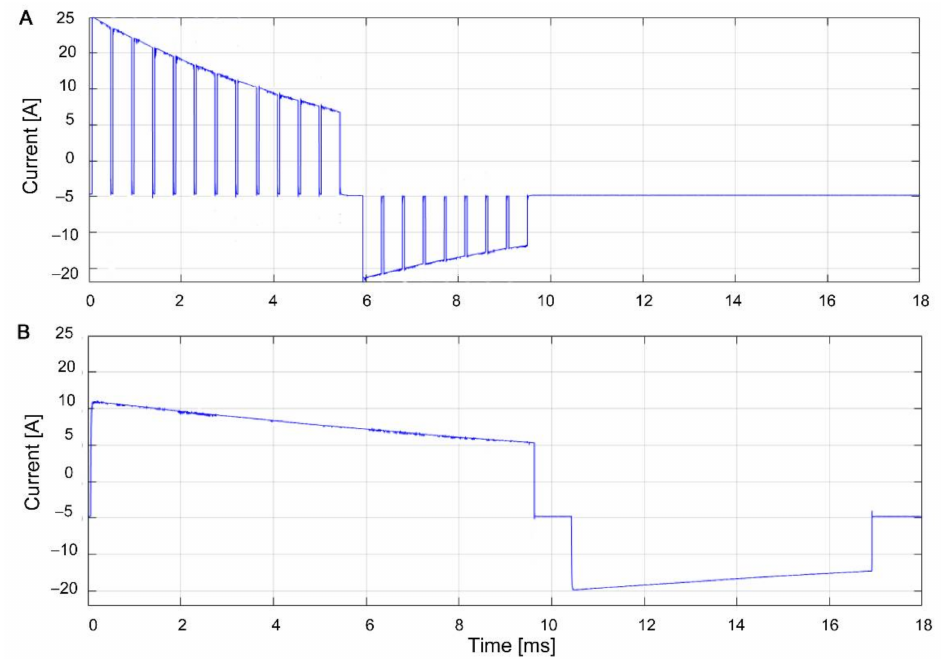
Figure 1. Recorded currents of studied defibrillation waveforms: ( A ) (PB generated with DGT7), ( B ) (BTE-HE generated with LP15). Both waveforms were digitized with the Defimpulse recorder under the same test conditions: selected energy (200 J) and patient impedance (100 Ω